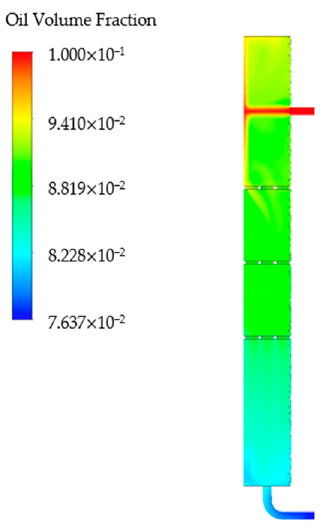
Figure 8. Oil phase volume distribution of four-hole plate.